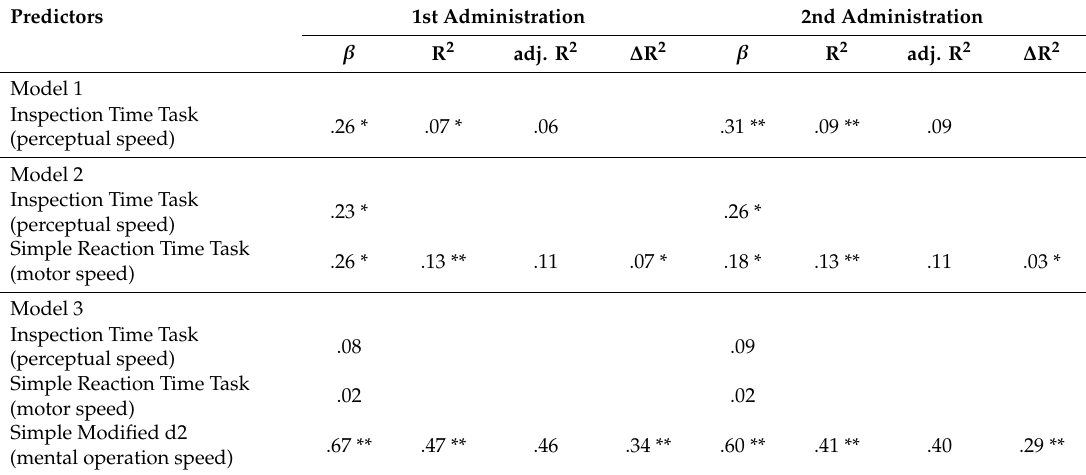
Table A1. Performance in the original d2-R test of sustained attention regressed on the tasks representing the sub-components of sustained attention tests (stepwise multiple